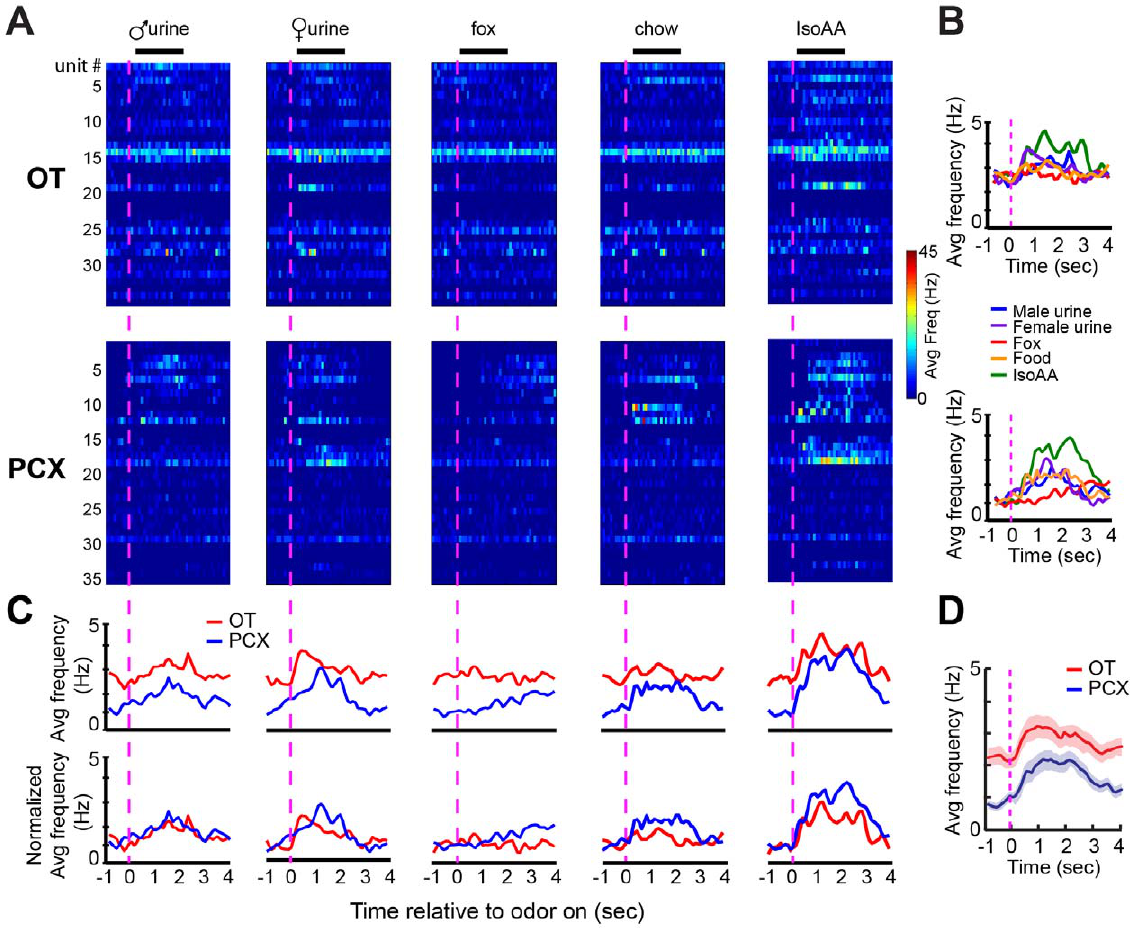
Figure 8. Temporal dynamics of odor-evoked activity in OT and PCX neural ensembles. ( A ) 3-dimensional histograms of average firing frequency for each unit across the five odors within the OT (top) and the PCX (bottom). Diversity of intensity in spontaneous firing and odor-evoked changes in firing are visible within both structures. Units arrangement ( # 1,2,3, etc.) is arbitrary but consistent across panels within regions. ( B ) Average firing frequency of OT (top) and PCX (bottom) units relative to odor onset sorted by odors. ( C ) Raw (top) and normalized (bottom) average firing frequency of OT and PCX units sorted by odors (left to right). ( D ) Average firing frequency across all odors and units. Data displayed as mean 6 SEM. Vertical magenta dashed line=odor